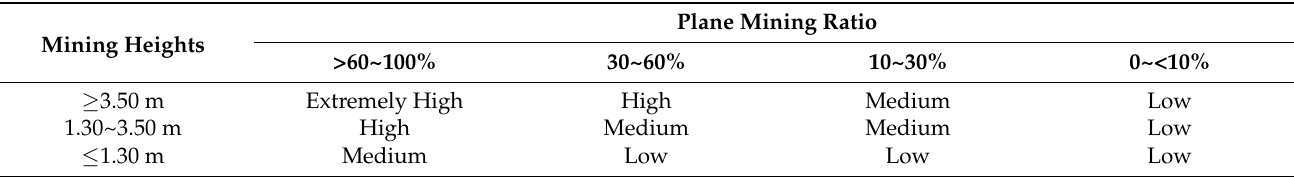
Table 3. Assessment of mining